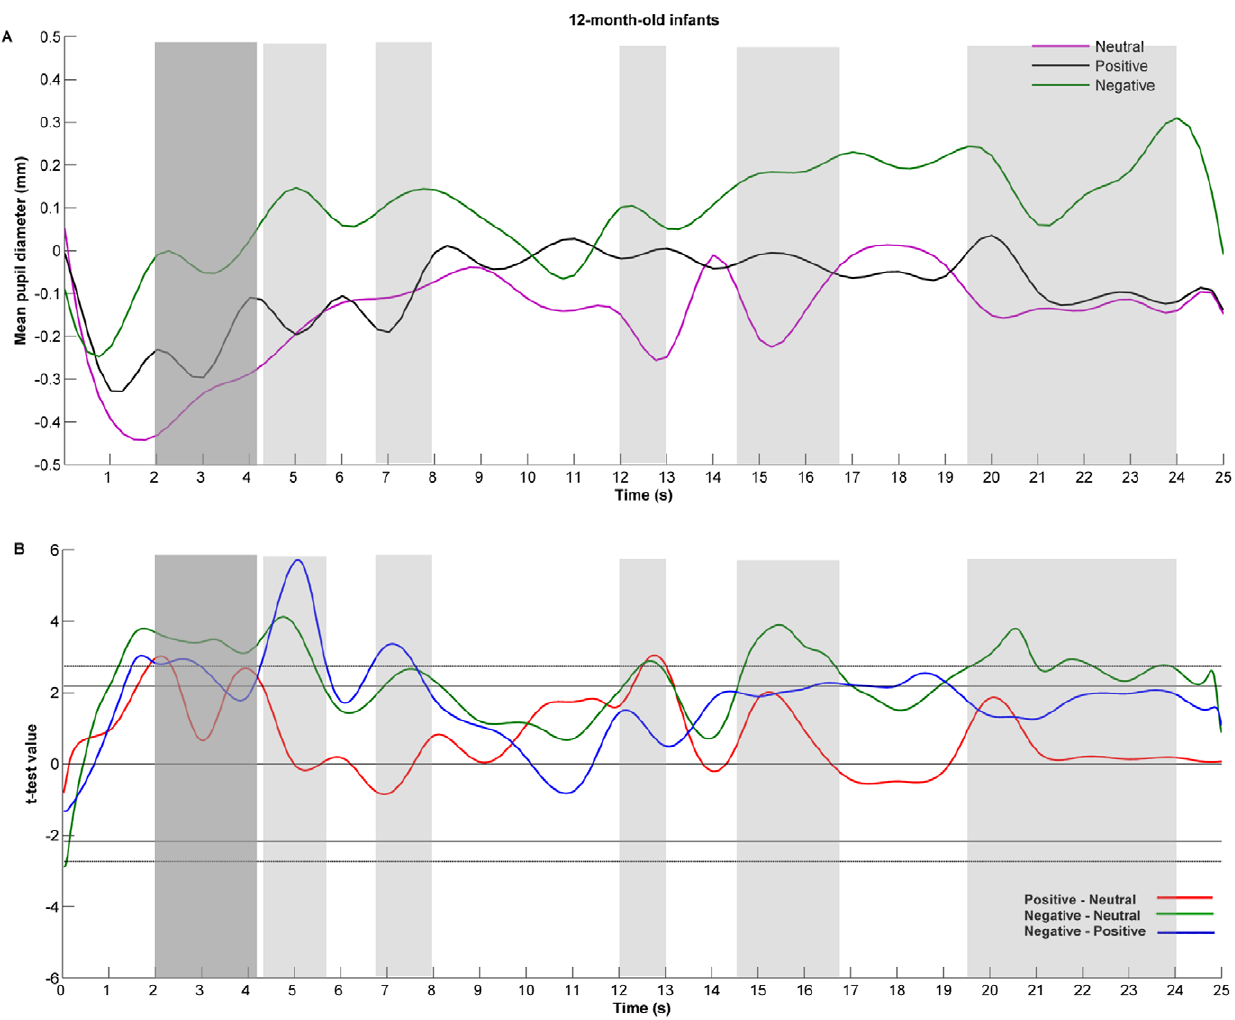
Figure 5. Twelve-month-old infants ’ pupil size changes in response to others ’ affective displays. In Panel A, functional expression of changes in the 12-month-olds baseline corrected pupil size in response to others’ neutral (purple line), positive (black line), and negative (green line) emotional displays. Panel B shows the value of t statistic as a function of time for each pair of stimuli comparison: positive vs. neutral (red line), negative vs. neutral (green line), and negative vs. positive (blue line). The one-tailed critical values of t are represented by the vertical lines with (dotted) and without (solid) Bonferroni correction for three comparisons. The difference is considered to be significant when this line is reached or surpassed. Marked with dark gray are those time windows in which both emotional conditions triggered larger pupil diameters than the neutral one, and the hypothesized negativity bias occurred. Marked with light gray are those time windows where negative emotions triggered larger pupil diameter compared to the emotionally neutral state. (Note that the shaded areas are for illustrative purposes only, marking the time window in which the effect occurred and not the effect duration.)